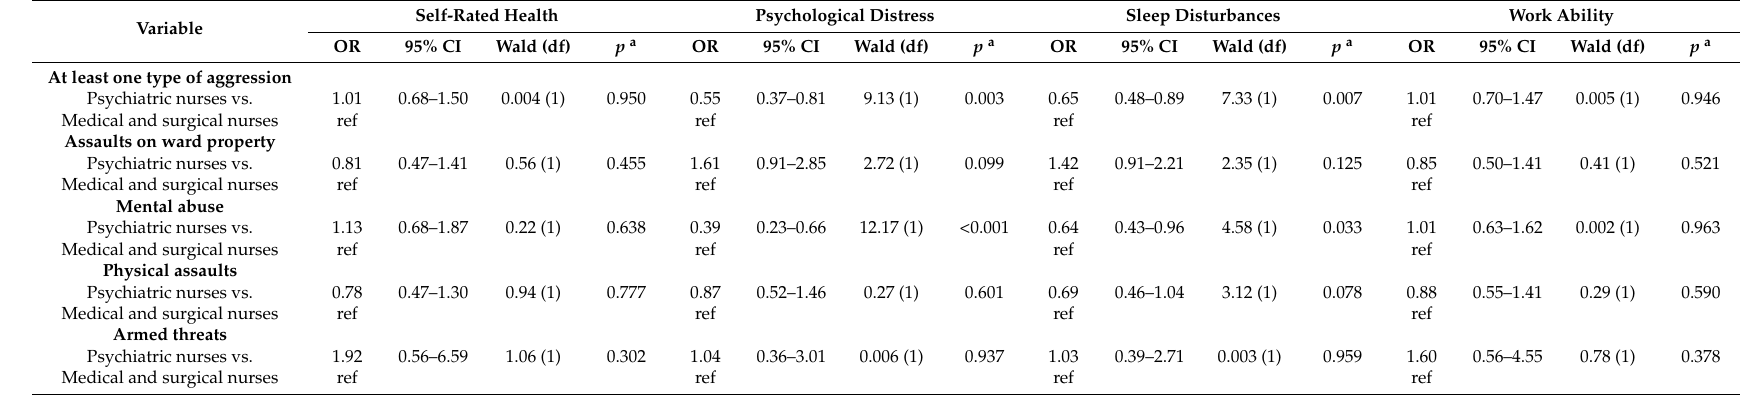
Table 6. Odds ratios (OR) and 95% confidence intervals (CI) comparing wellbeing outcomes between nurses in psychiatric and emergency specialties having encountered different types of aggression in their work (Finland, 2012). Self-Rated Health Psychological Distress Sleep Disturbances Work Ability Variable OR 95% CI Wald (df) p a OR 95%CI Wald (df) p a OR p a Wald (df) p a At least one type of aggression Psychiatric nurses vs. Assaults on ward property Psychiatric nurses vs. Psychiatric nurses